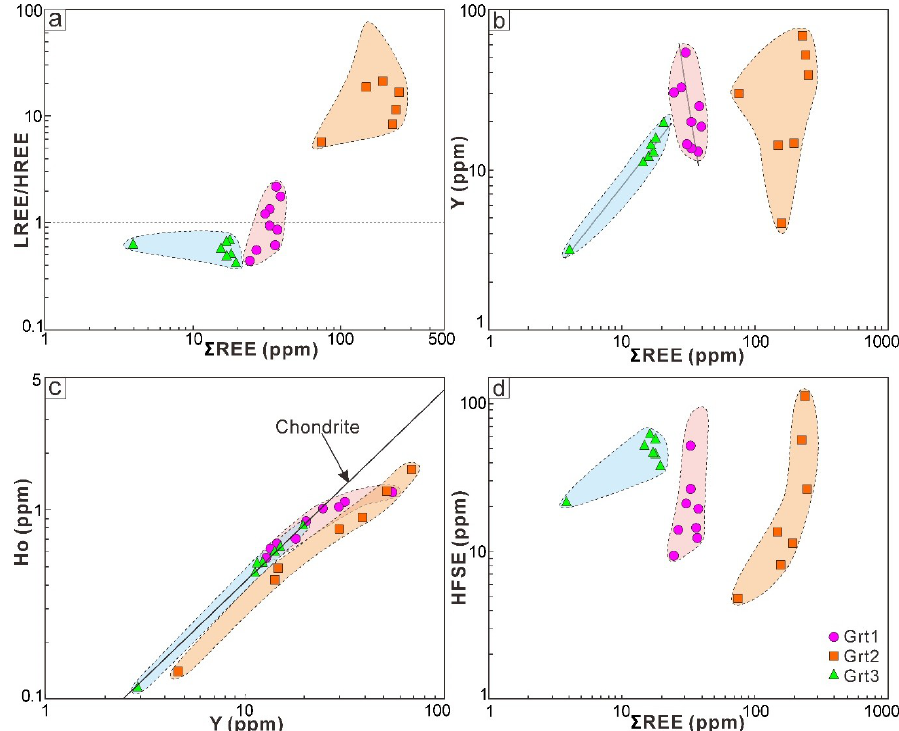
Figure 14. Binary plots of ( a ) total rare earth element ( Σ REE) versus light and heavy rare earth element (LREE / HREE), ( b ) Σ REE versus Y, ( c ) Y versus Ho, and ( d ) Σ REE versus high field strength element (HFSE) for garnets from the Yamansu deposit. The chondritic Y / Ho ratio ( c ) is from